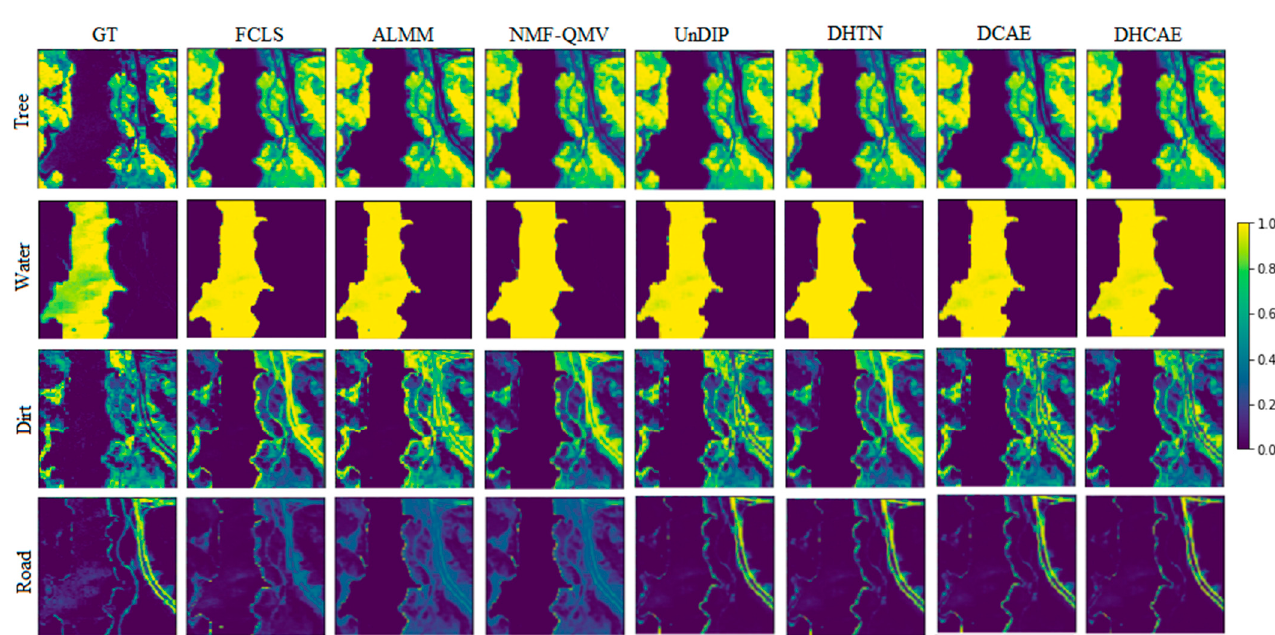
Figure 9. Jasper Ridge data. Ground truth (GT) map in the first column and extracted abundance maps without noisy bands comparison by different spectral unmixing methods.